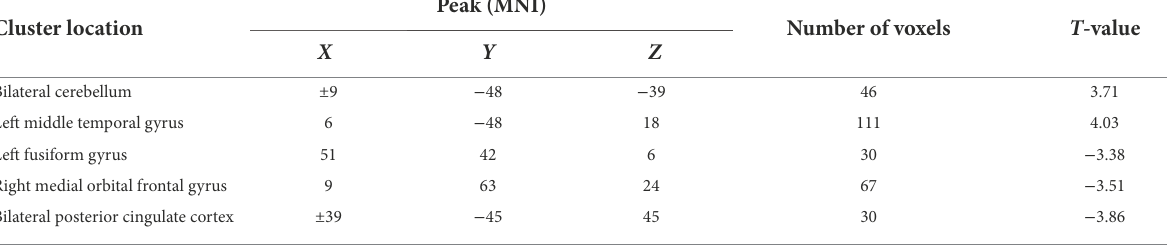
TABLE 2 Alterations of DC between patients and controls. (at baseline, after treatment) and controls.